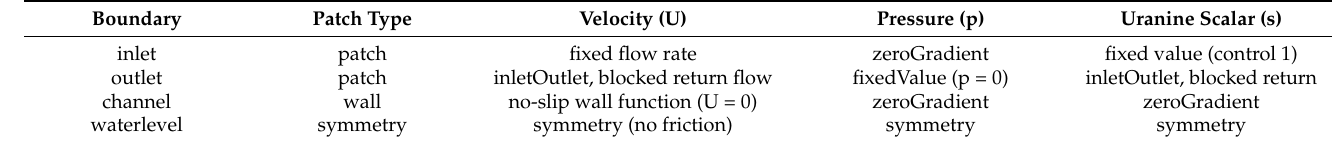
Table 1. Boundary conditions for fields U, p, and